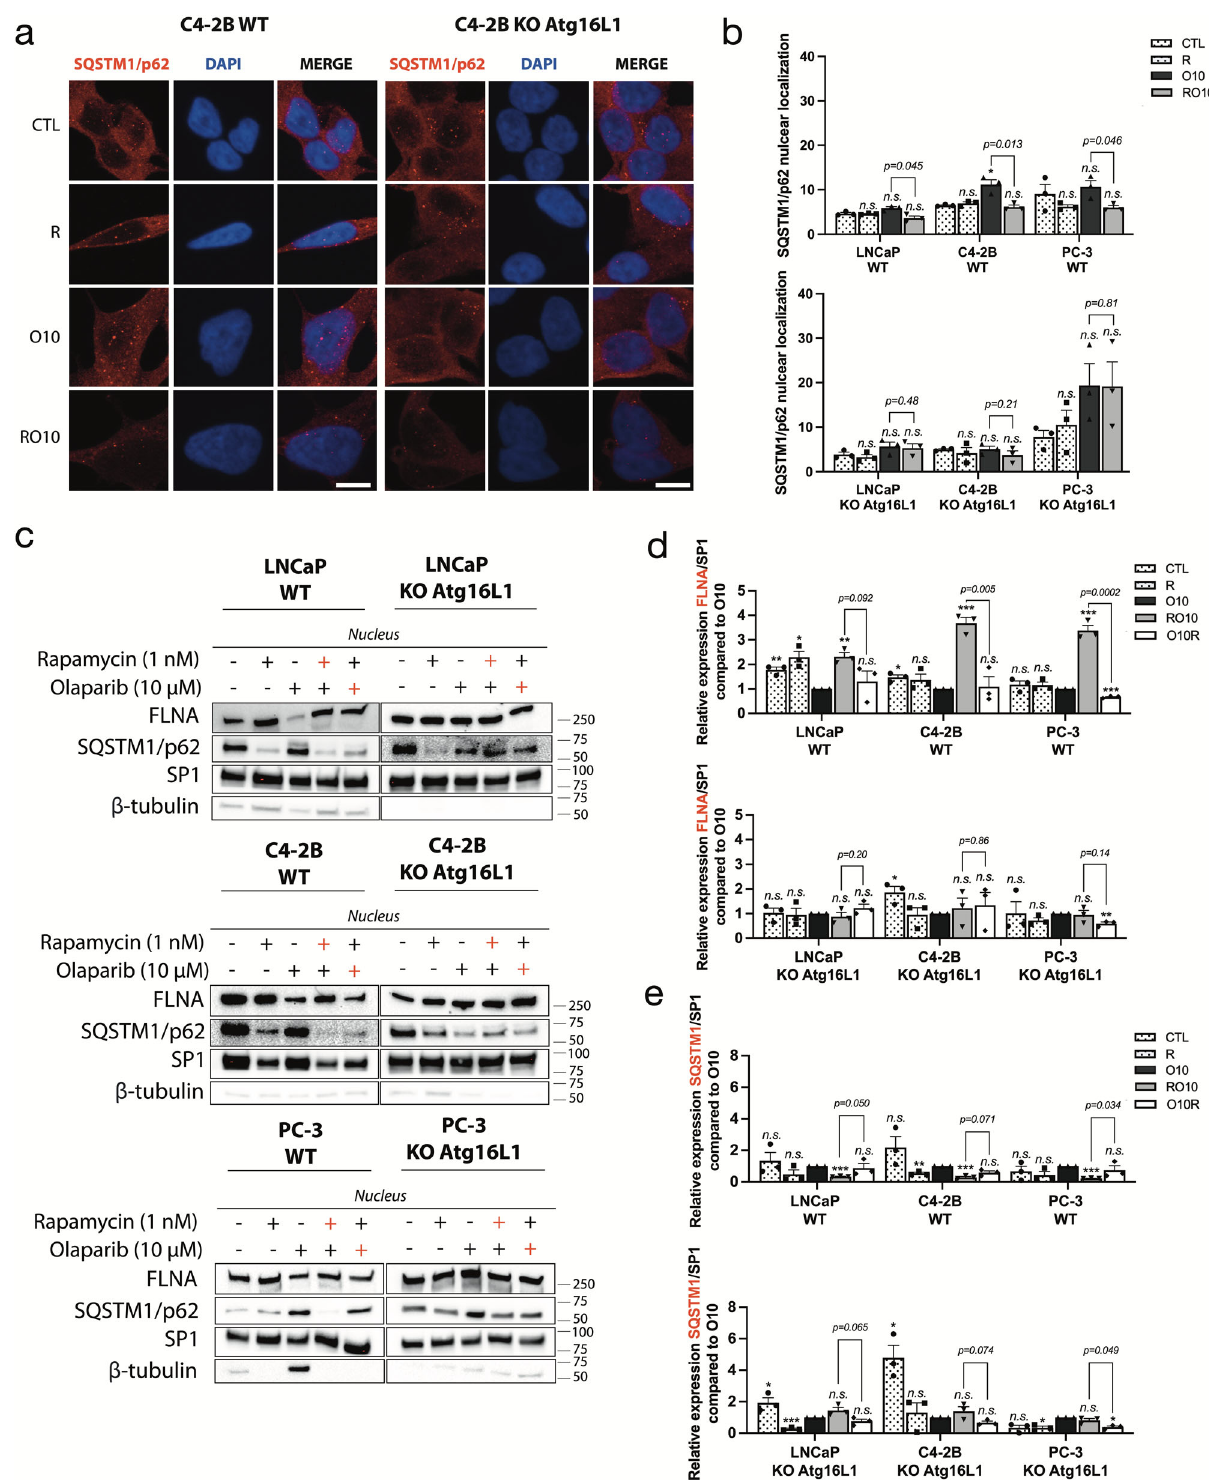
Fig. 5 SQSTM1/p62 nuclear localization regulates autophagy-mediated resistance to olaparib. a Representative images (C4-2B WT and KO Atg16L1 ) of the number of SQSTM1/p62 puncta following rapamycin alone (R), O10 or RO10 treatments after 2 days. b Quanti fi cation of nuclear SQSTM1/p62 in WT and KO cell lines. c Western blot of nuclear fraction after 2 days of RO10 and O10R treatment in PC WT and KO Atg16L1 cell lines. Rapamycin (red + ) denotes RO10. Olaparib (red + ) denotes O10R. ß-tubulin was used as quality control as a marker of cytoplasmic fraction and SP1 as a marker of the nuclear fraction. d , e Relative expression of FLNA and SQSTM1 normalized with SP1 and compared to O10 condition. For all data, the mean ± SEM of three independent experiments is shown. Data were analyzed using the two-tail Student t -test. n.s. = nonsigni fi cant. * p < 0.05, ** p < 0.01, and *** p < 0.001. Scale bar 10 µ